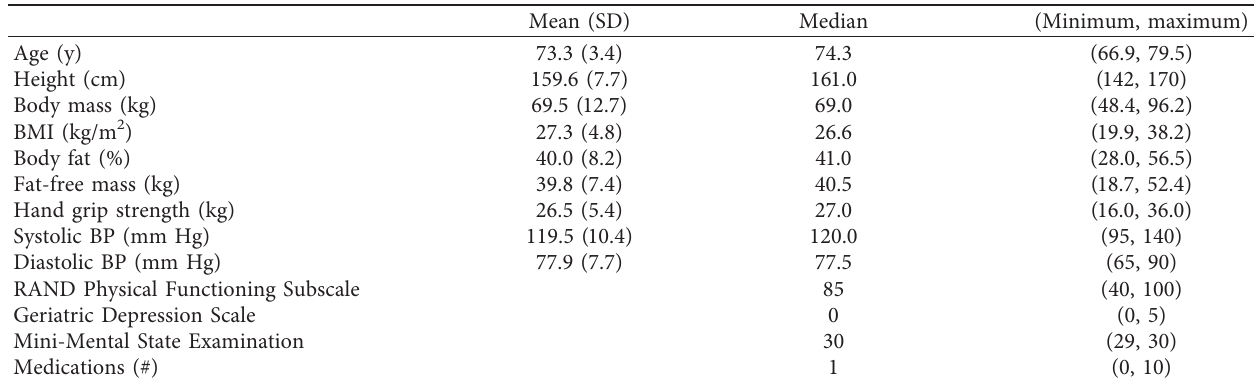
Table 1: Baseline characteristics of participants ( n � 18).